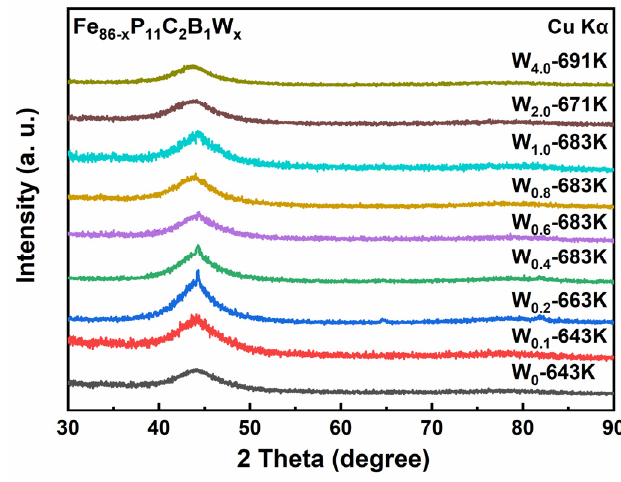
Figure 4. XRD patterns of the annealed Fe 86 − x P 11 C 2 B 1 W x ribbons.